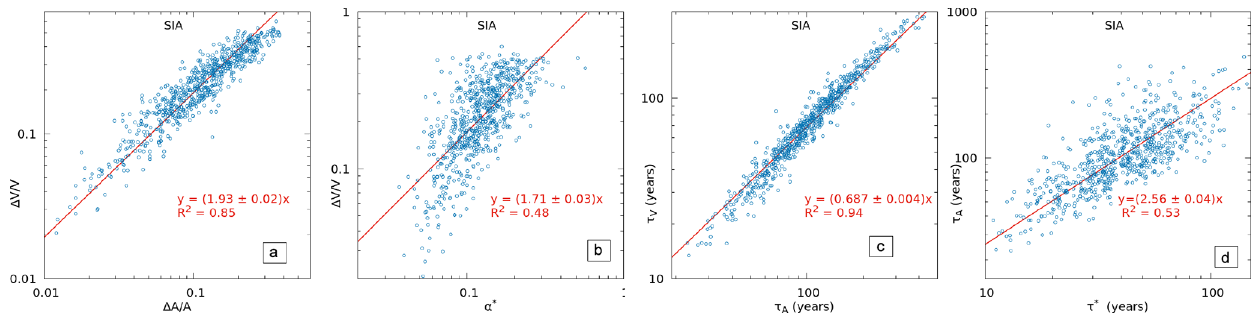
Figure 3. Results from the SIA simulations of the 703 synthetic Himalayan glacier show that (a) the climate sensitivities of area and volume are proportional to each other, (b) the climate sensitivity of glacier volume is proportional to α ∗ = βδEτ with glaciers area and volume are proportional to each other, and (d) the volume response time is proportional to τ ∗ = − fitted functions are shown with red lines. The corresponding fit parameters and R 2 of the fits are also given. See text for detailed